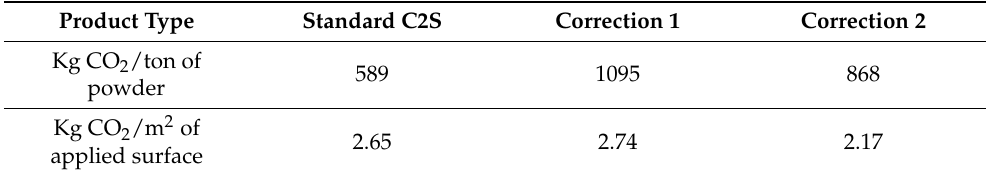
Table 3. CO 2 emission evaluation for three tile adhesives (standard version and corrected versions with rubber introduction) according to different sources (module